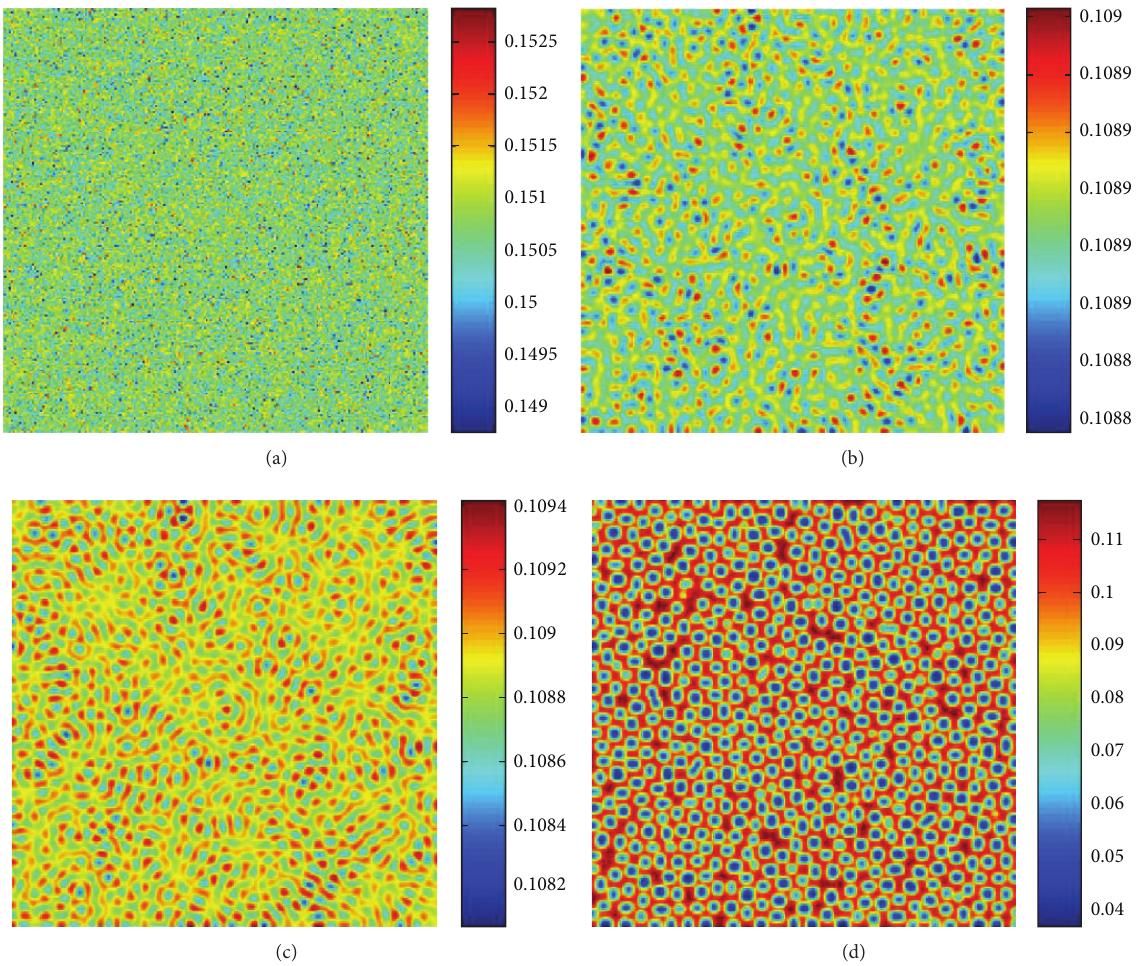
Figure 6: Snapshots of the time evolution of the prey at different instants with 𝛼 = 0 . 6, 𝛽 = 1 . 5, 𝛾 = − 0 . 3, 𝛿 = 1 . 1, 𝜃 = 2 . 2, 𝑑 1 = 0 . 08, 𝑑 2 = 1, and 𝜏 = 0 . 02, which are in the Turing space. (a) 0 iterations; (b) 10000 iterations; (c) 50000 iterations; (d) 100000